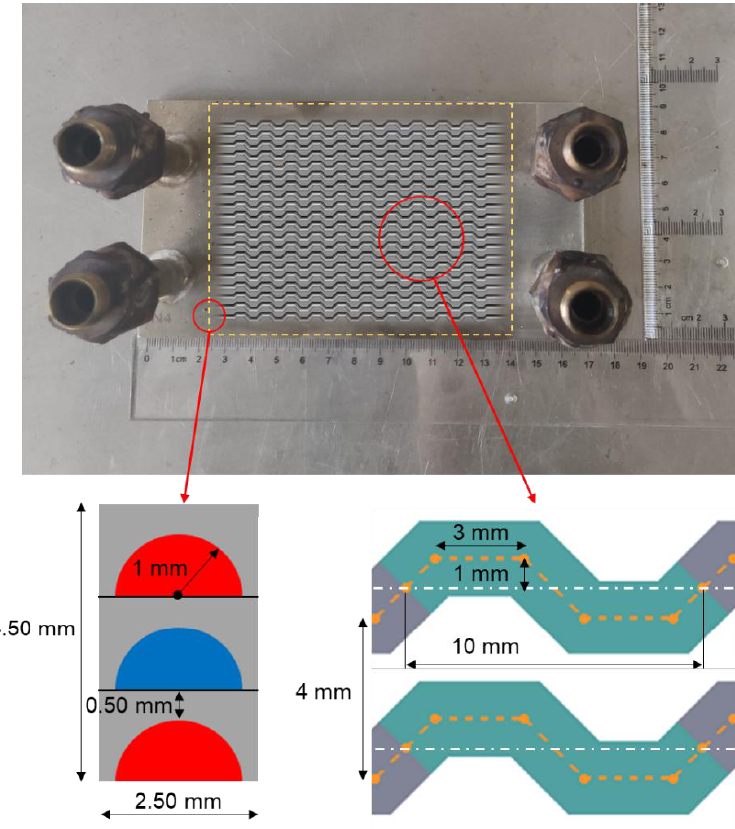
Figure 2. The test trapezoidal PCHE prototype and its channel geometric parameters. The experimental test conditions are shown in Table 1. Table 1. The experimental test conditions.